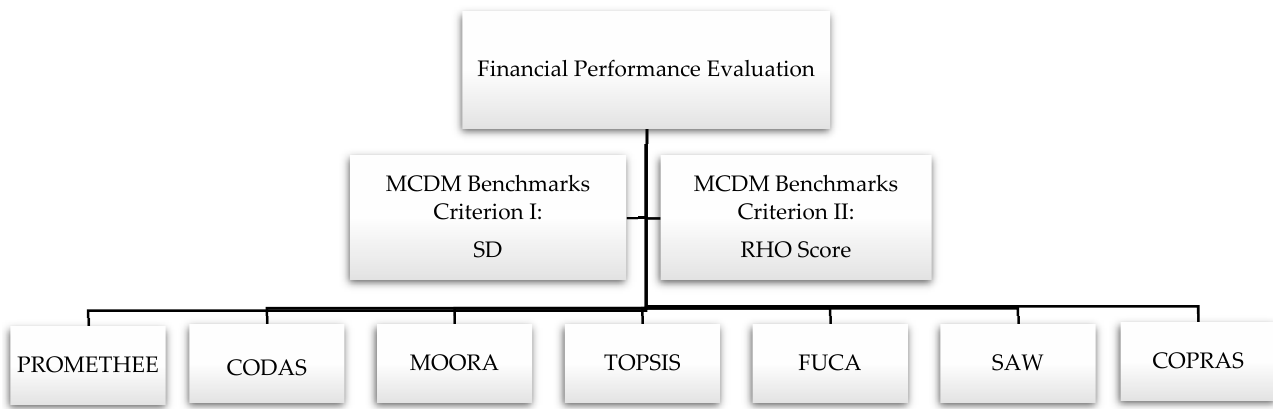
Figure 1. The Diagram of the Experimental Process.